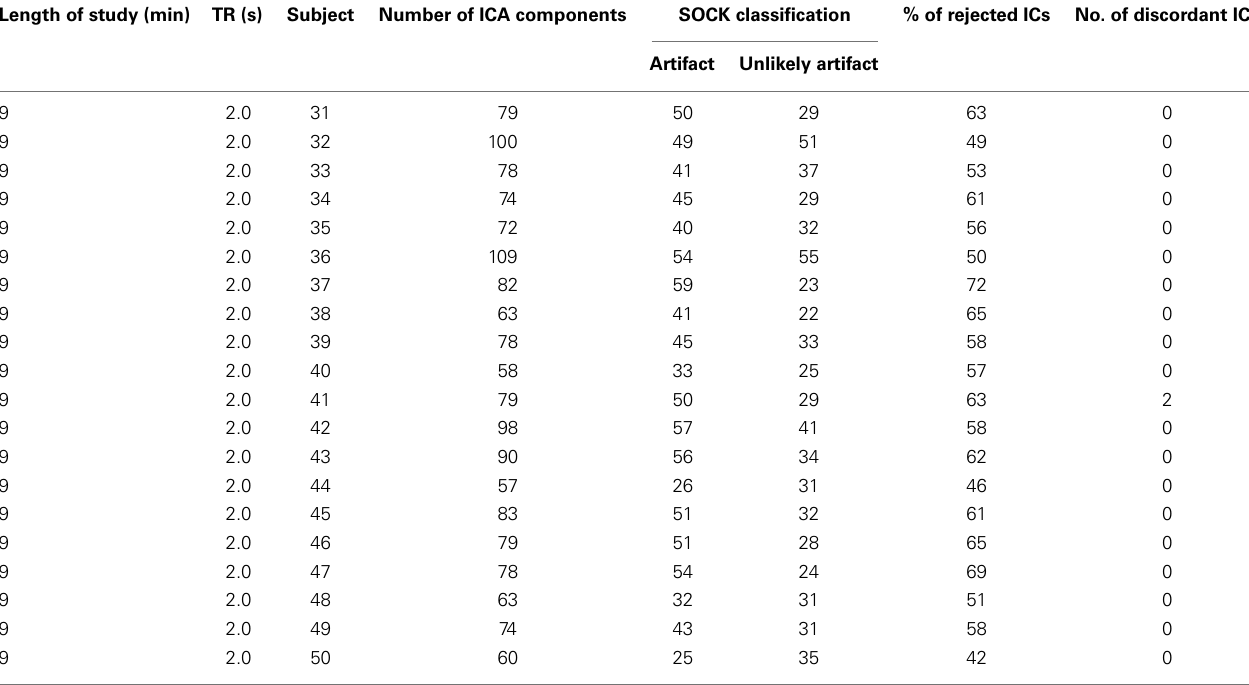
TableA3 | ICA decomposition and the SOCK classification for 20 healthy controls who underwent a 9min resting-state fMRI withTR of 2.0s. Length of study (min) TR (s) Subject Number of ICA components SOCK classification % of rejected ICs No. of discordant ICs Artifact Unlikely